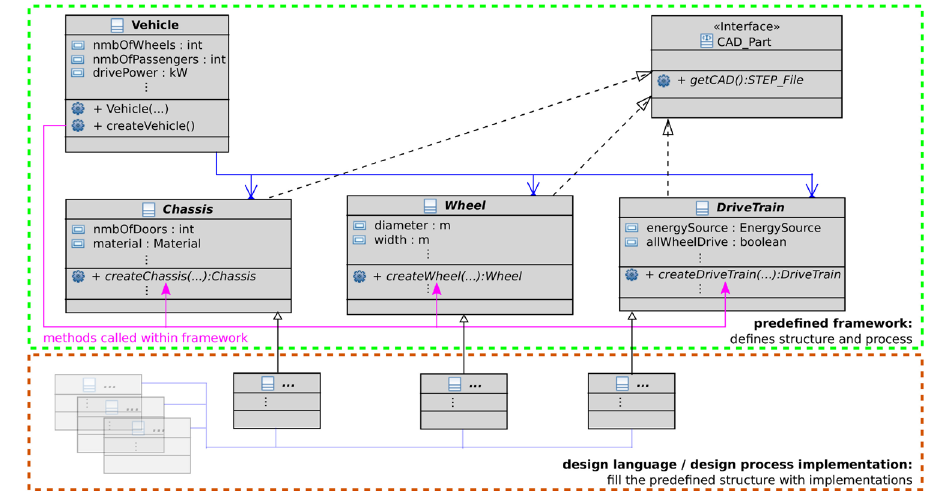
Fig. 19 A existing framework defines the product’s struc- ture and the product’s design process through abstract interfaces and abstract classes (italic labels). The concrete design language implements the predefined methods and classes of the